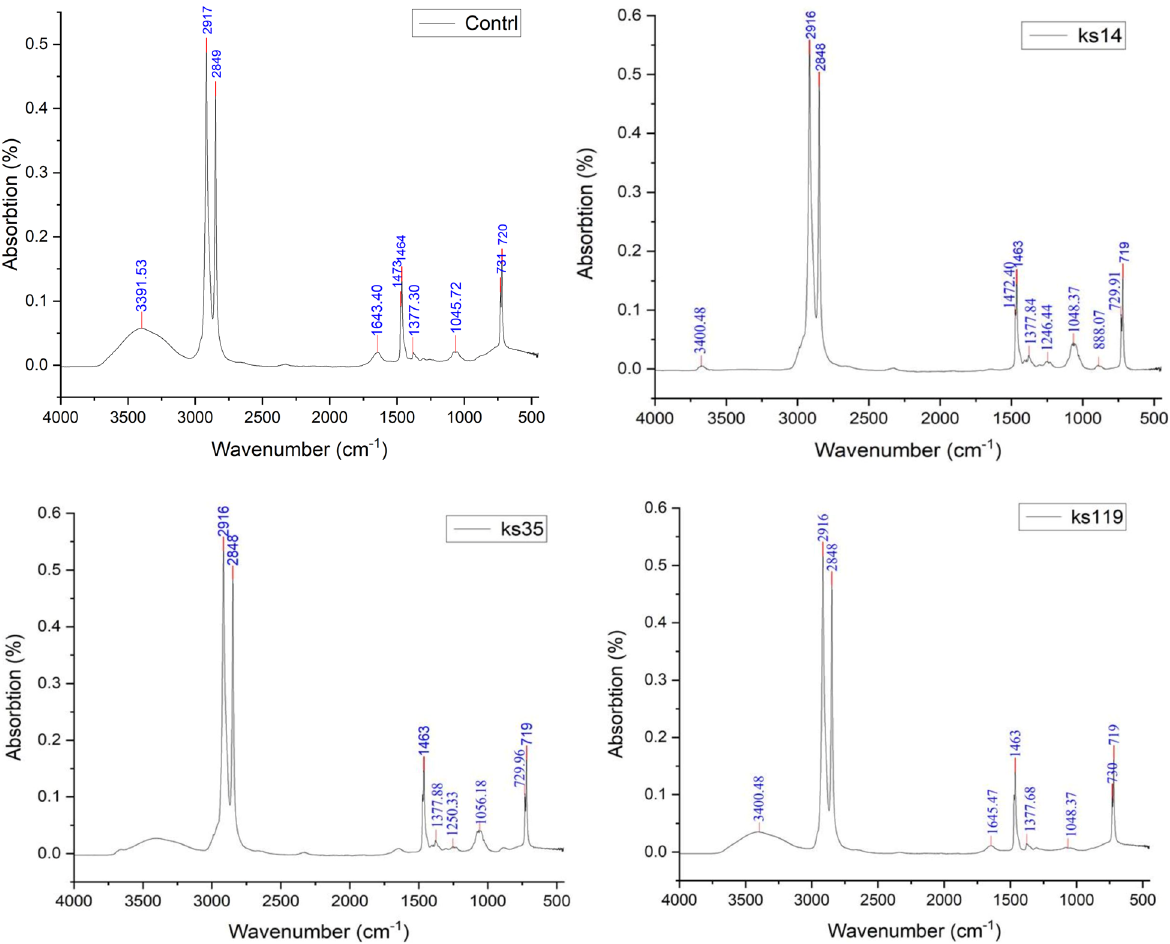
Fig. 4 FT-IR spectra of polyethylene sheet treated with bacterial inoculum and the control incubated at 35 °C for 60 days. Peak at 1643.78 cm − 1 which represent C–C C stretch of alkenes disappeared in all bacterial-treated LDPE film except KS 119-treated film. New peaks at 1250.9 cm − 1 and = 1246.44 cm 1 attribute to C–O stretch of ester’s −